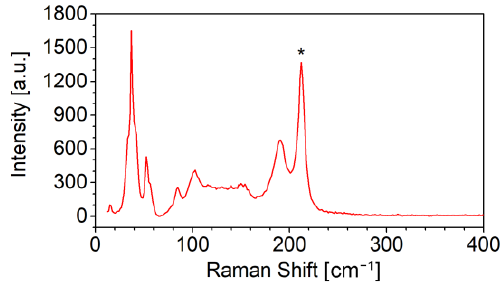
Figure 1. Raman spectrum collected on a local spot of a thin-film deposited by LT-PED with a Sb 1.5 Cu 0.5 Se 3 target, where CuSbSe 2 phase was also present, as revealed by the peak at ~210 cm −1 (highlighted with * symbol). All the other main peaks in the spectrum are typical of a Sb 2 Se 3 -like phase [36].